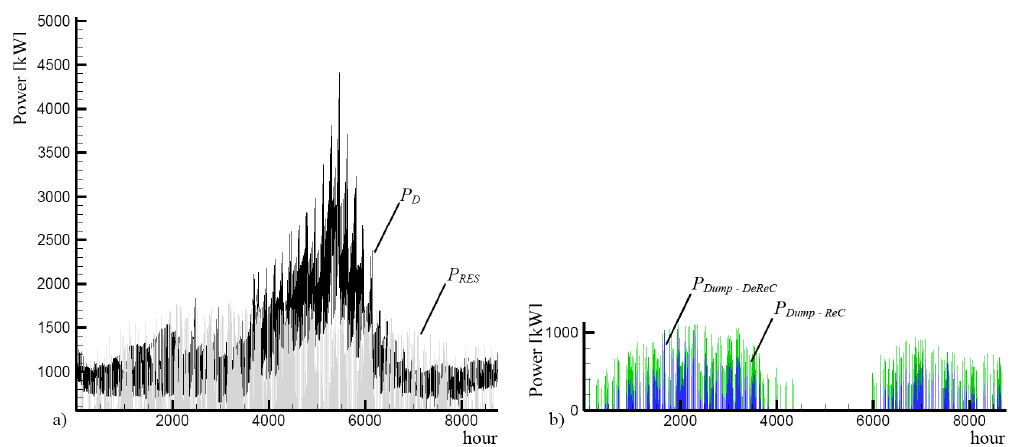
Figure 6. Hourly based curves for ( a ) user load (P D , black line) and renewable power availability (P RES , grey line) during a reference year and ( b ) dumped power in the ReC (P Dump-ReC , green line) and DeReC (P Dump-DeReC , blue line), during a reference year.